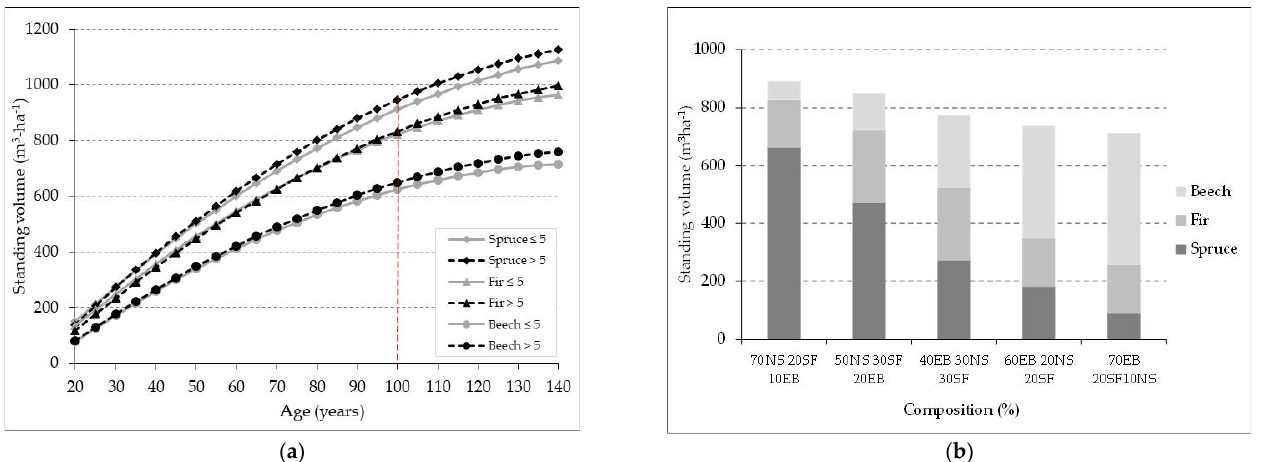
Figure 5. ( a ) Model-predicted standing volume yield at age 100 (models in Table 8) for spruce, fir, and beech in mixed stands; and ( b ) standing volume yield from five mixture types at age 100. The models simulated the V for cases where the p sp was between 10 and 50% (p sp ≤ 5) and between 60 and 90% (p sp > 5). The values predicted by the models were extended to a density of 1.0. When they were used for stands with other densities, the values indicated by the models had to be adjusted to the actual density of each species. In addition, to express increases in the V and MAI in the mixtures, the projected model values had to be reduced by the p sp . Table 8. Statistical parameters of the models used in the relationship between species proportion and stand productivity.